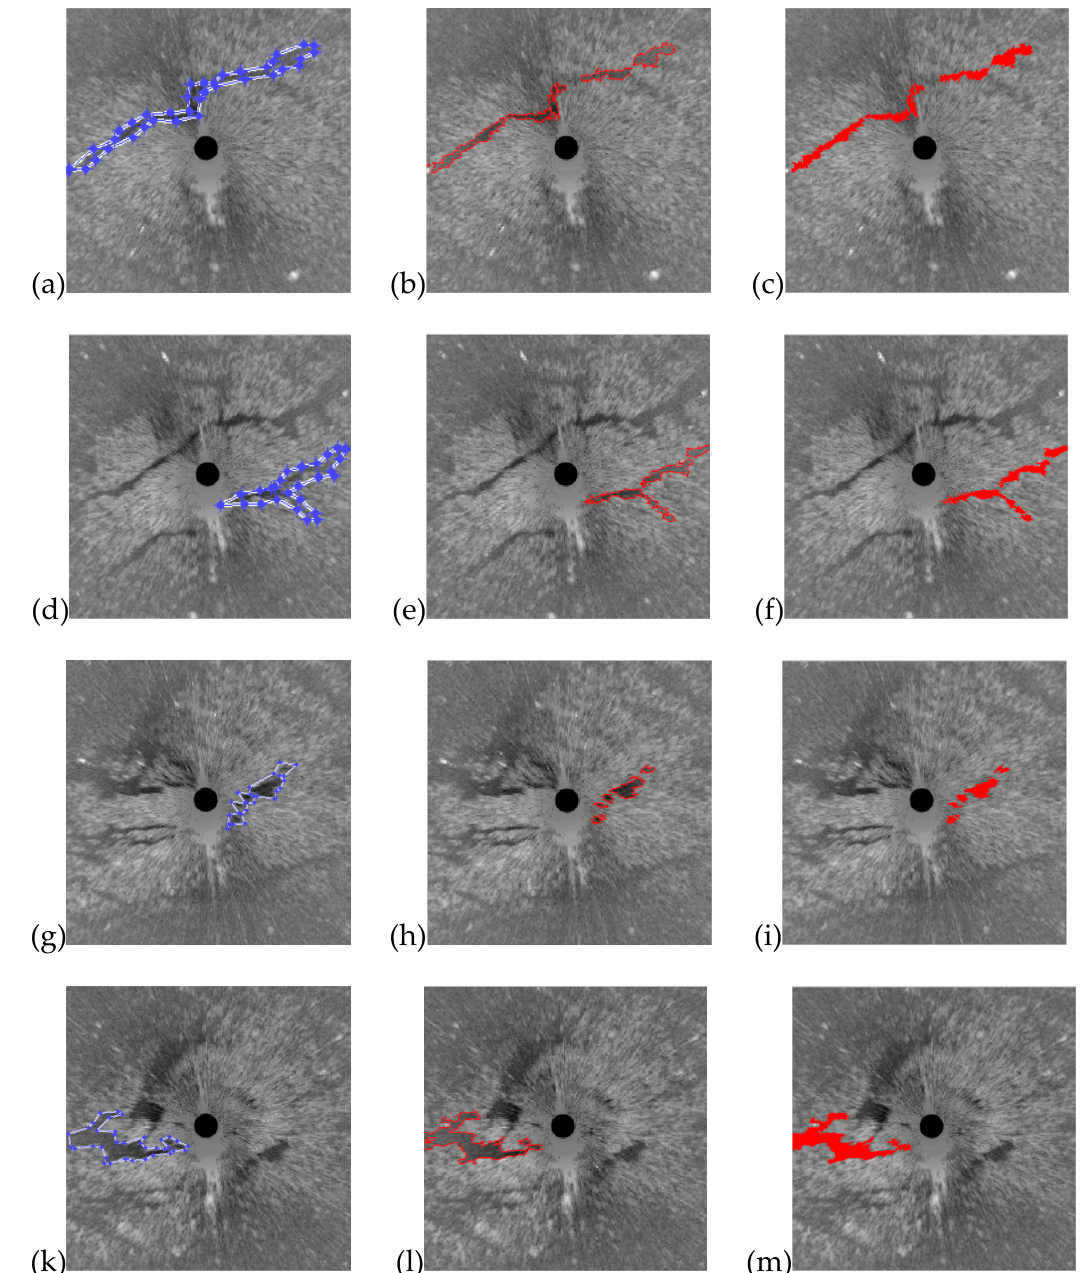
Figure 15. Local Binary Fitting (LBF) model results: ( a ), ( d ), ( g ), and ( k ) are the pre-set contours; ( b ), ( e ), ( h ), and ( l ) show the LBF model results; and ( c ), ( f ), ( i ), and ( m ) are the final results of our model. Table 2. The area of identified oil-films. Figure ID